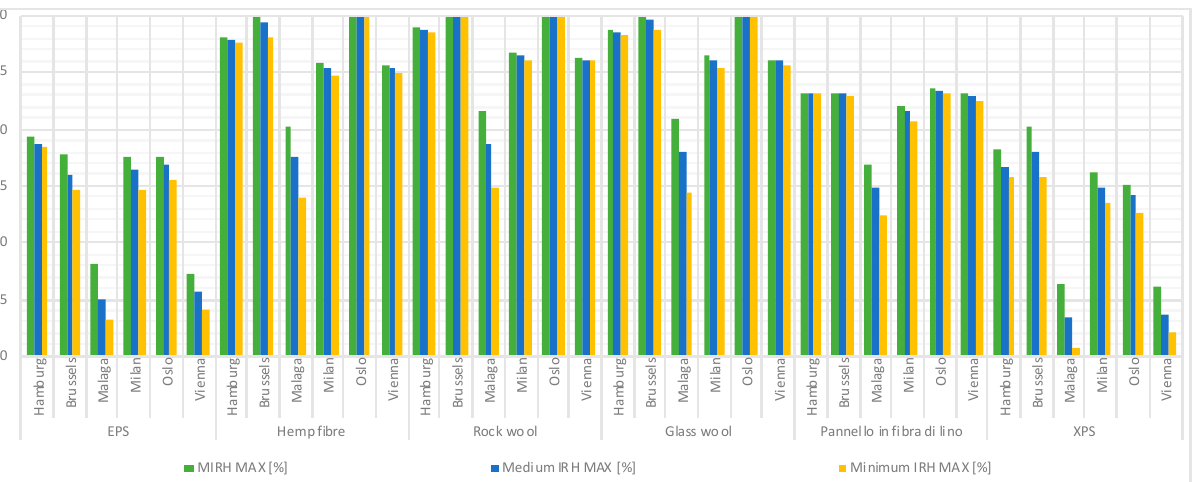
Figure 5. Results of MWCI values, average and minimum (kg/m 2 ), divided by type of insulation and application scenario. Table 5. Results in terms of orientation, location, and type of insulation of the presence or absence of interstitial condensation between the insulation and existing masonry. City